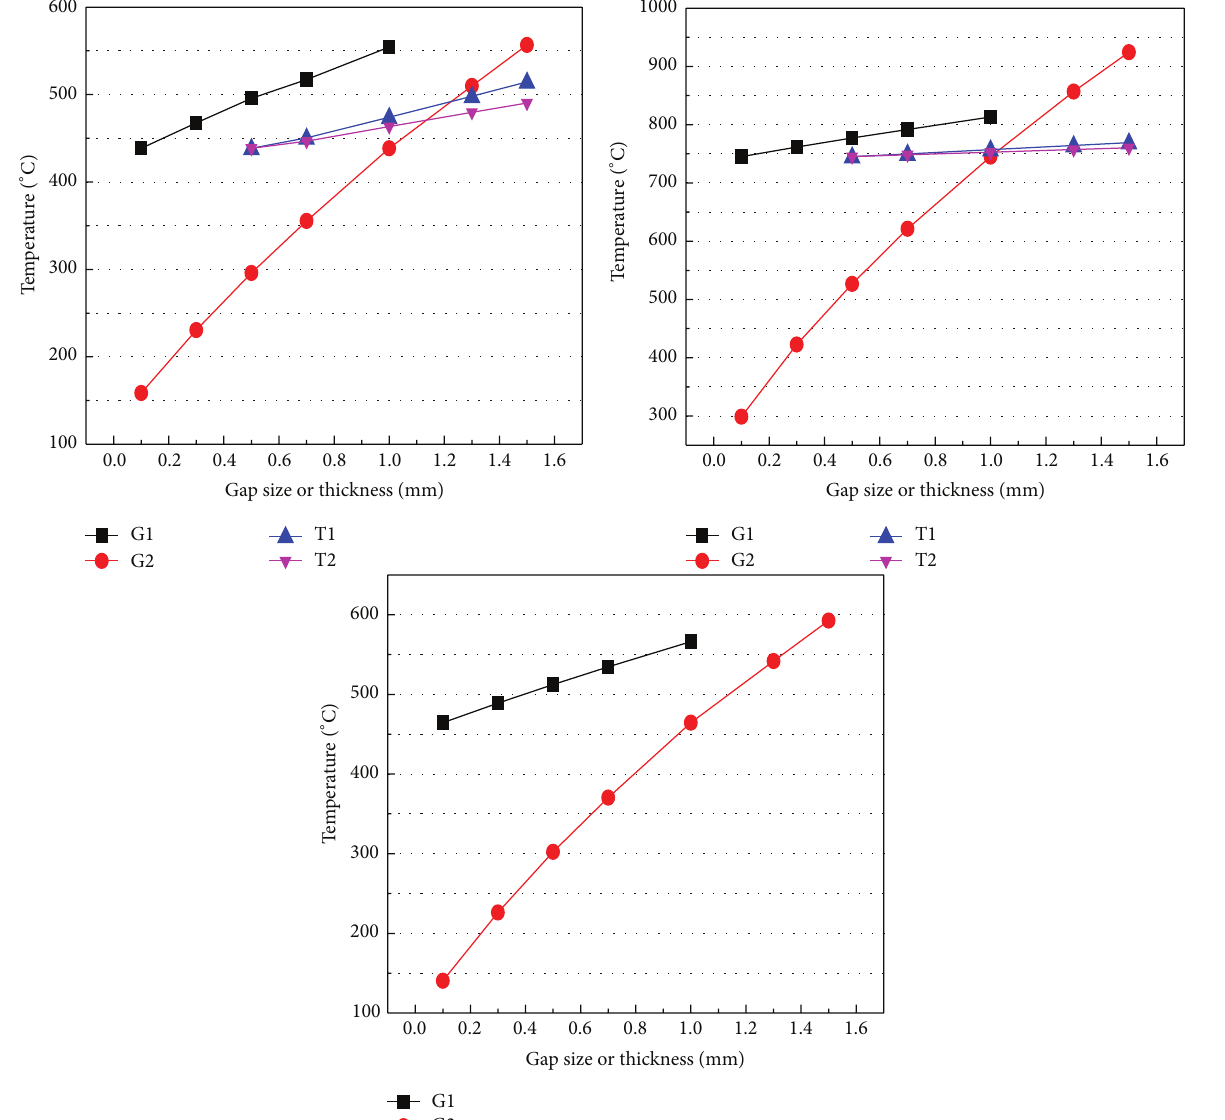
Figure6:EffectsofgapsG1andG2andcontainerthicknessesT1andT2onthespecimentemperature(fromtheleft;capsulewithNaK/LBE/Al thermal